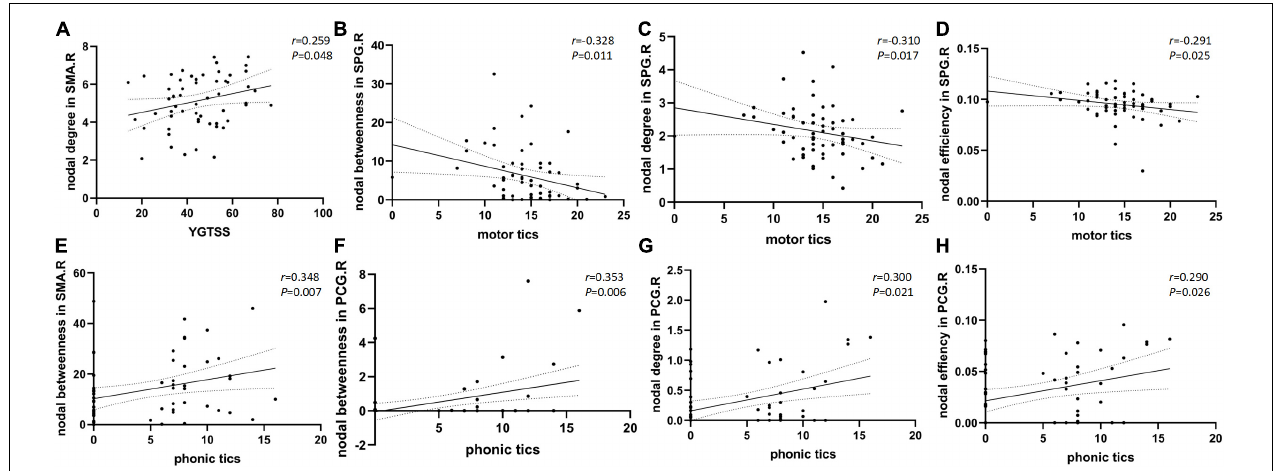
FIGURE 2 | Scatter plots with 95% confidence interval (CI) of nodal brain network properties of different regions compared to YGTSS total scores (A) and sub scores of motor tics (B–D) and phonic tics (E–H) .